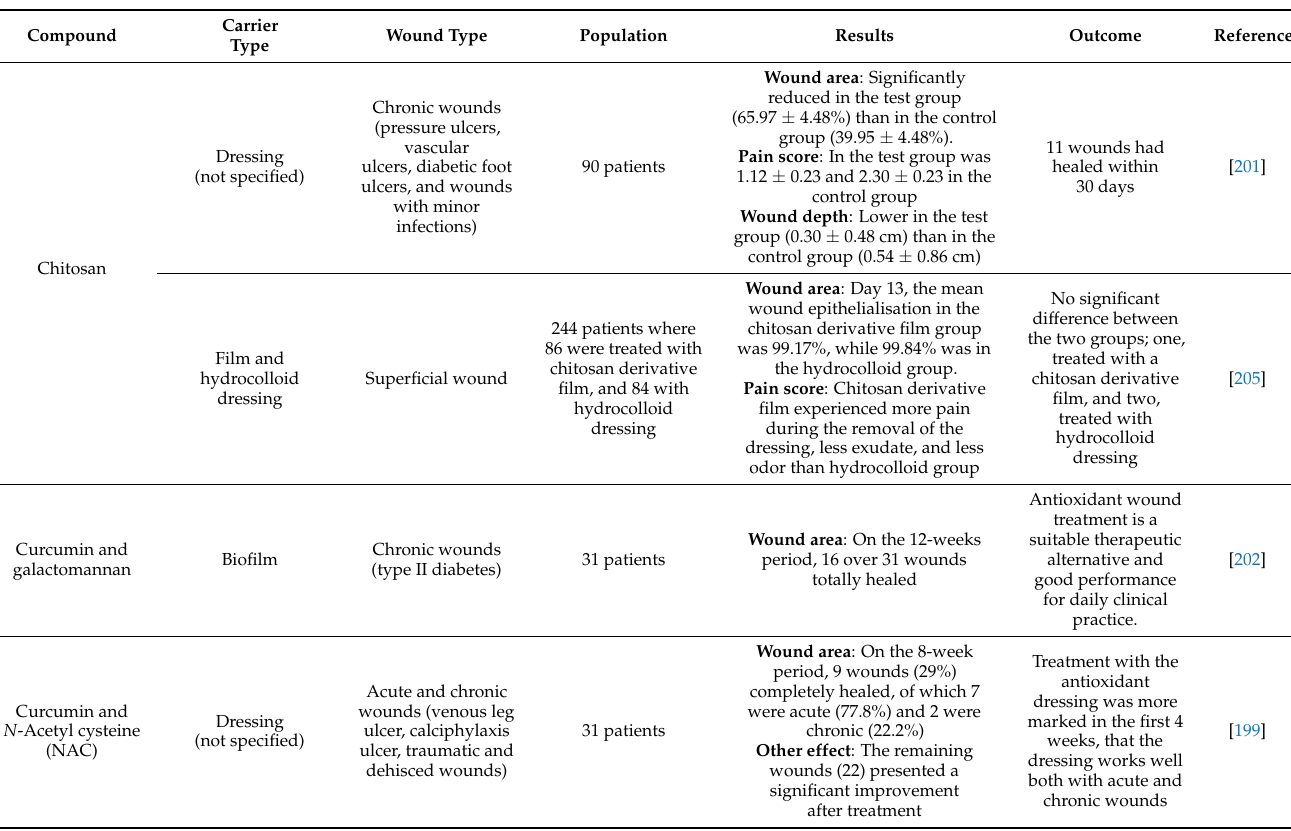
Table 6. Studies about the effect of antioxidant compounds as biomaterials on the wound healing process (clinical